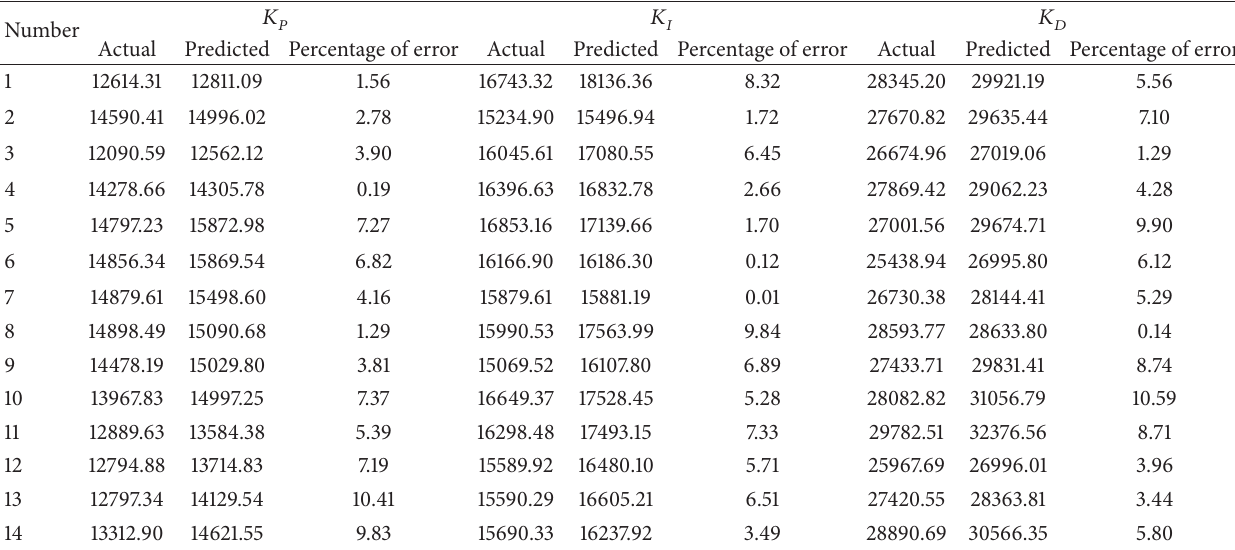
Table 10: Comparison between actual gain parameters of PID and the BPN model (with newcf